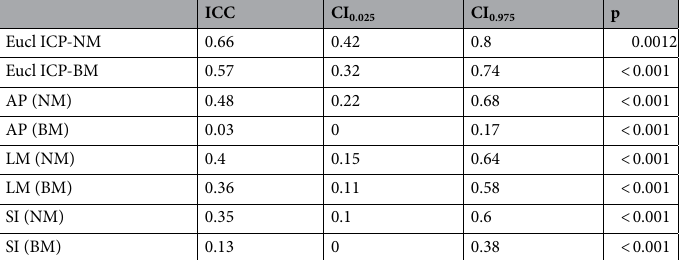
Table 4. Interclass correlation coefficients (ICCs) of Euclidean 3D distances and 1D data for comparison between MRI and CPI. P-values refer to the hypothesis ICC = 1, n = 40. CI confidence interval, Eucl Euclidean distance, ICP intercuspal position, NM neuromuscular position, BM bimanual manipulation, AP anterior– posterior, LM latera–medial, SI